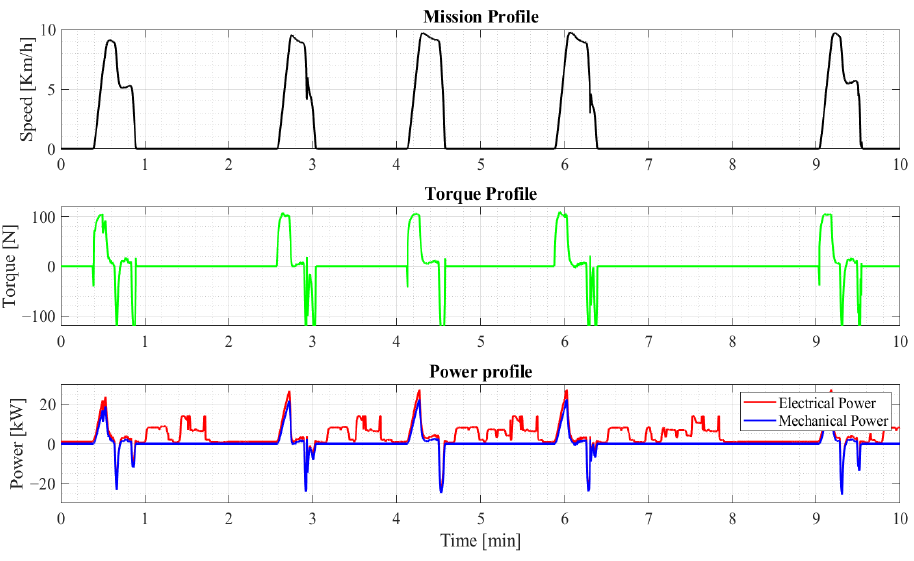
Figure 11. View of speed, torque, and power profile acquired during experimental tests.